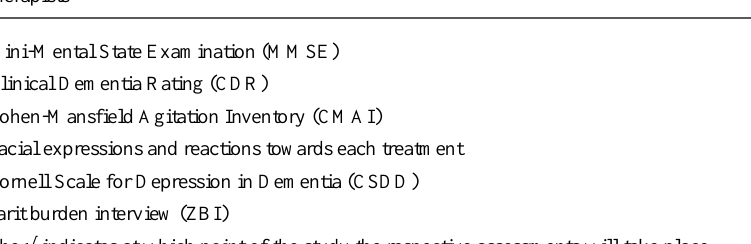
Post-treatmentTreatment